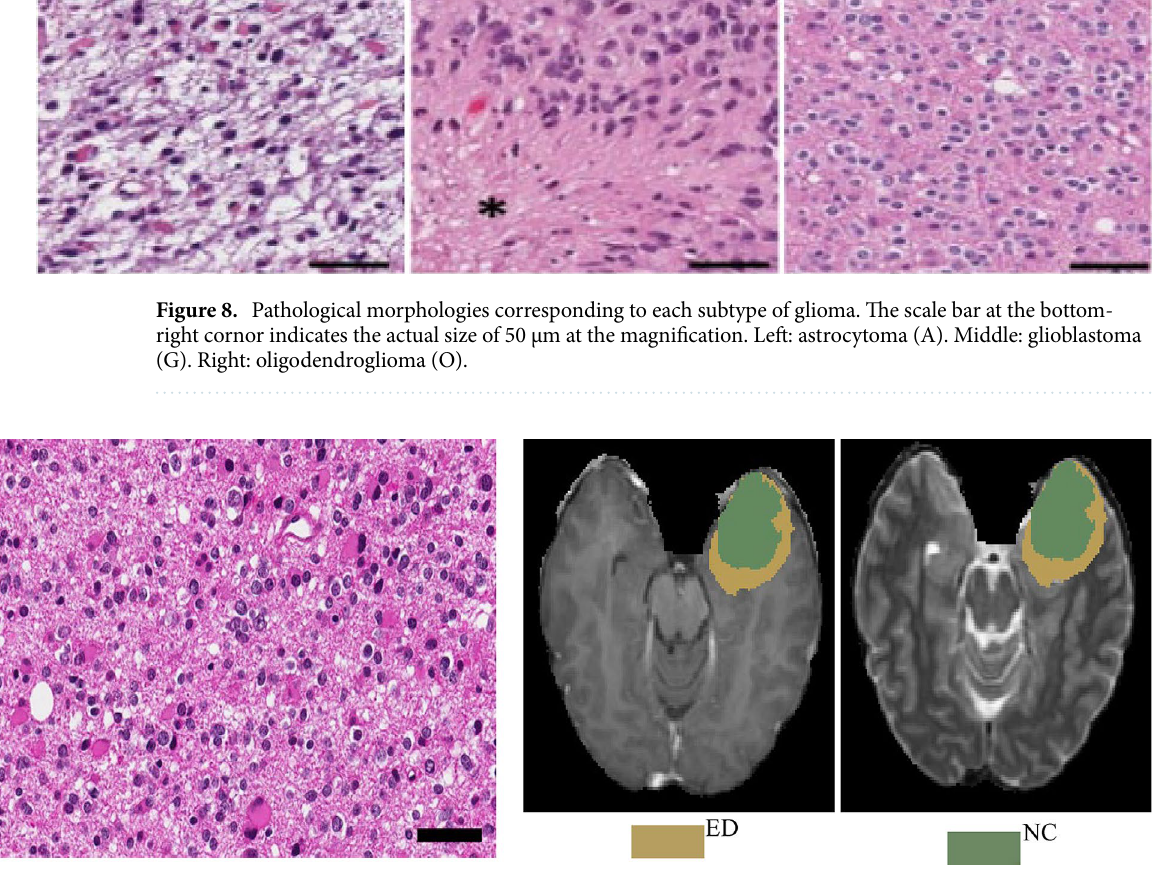
Figure 9. One of the cases that was overdiagnosed by the WSI-based approach but successfully corrected by the MRI-based approach after the proposed label agreement scheme. Left: Pathological observation. Right: The brain tumor segmentation on